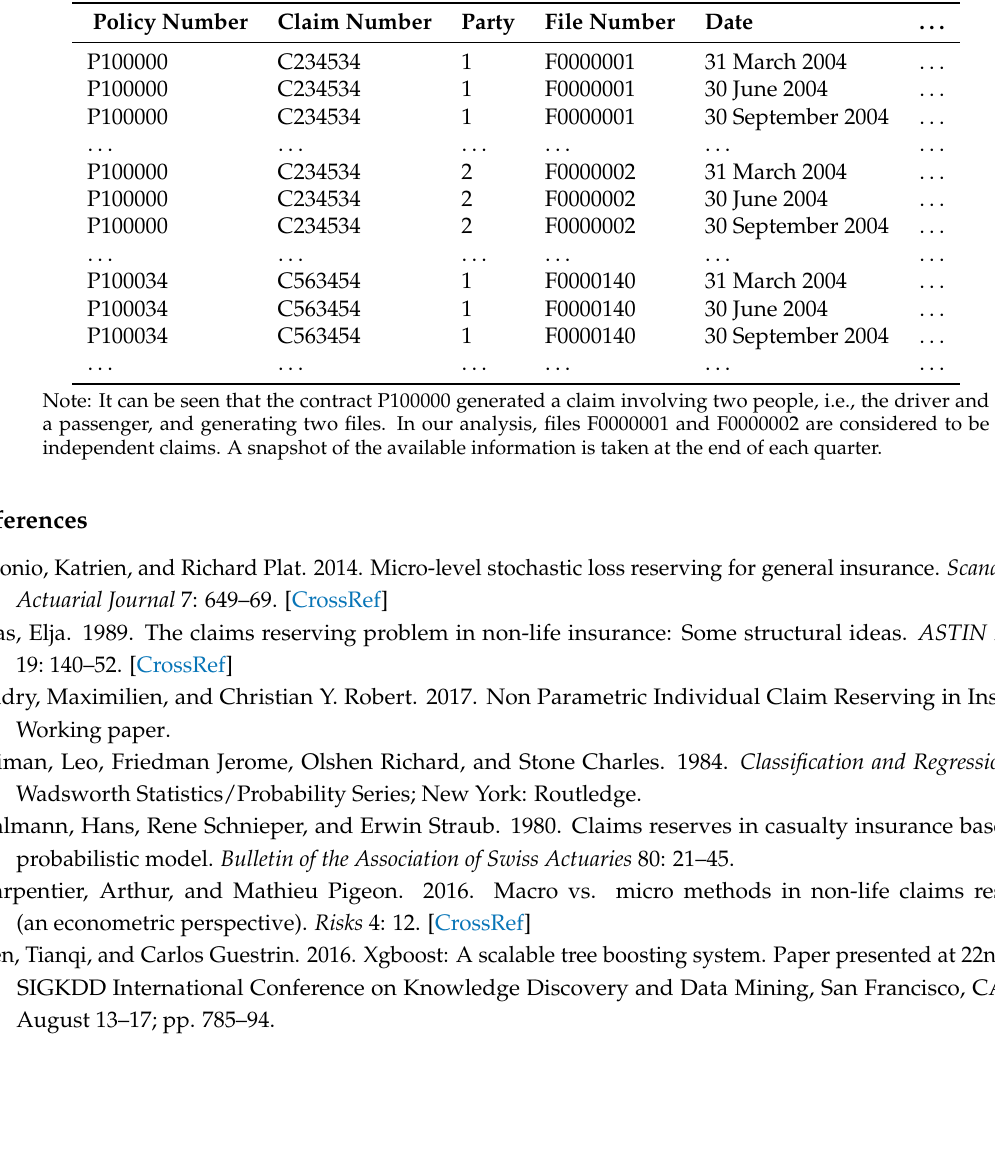
Table A1. An example of the structure of the